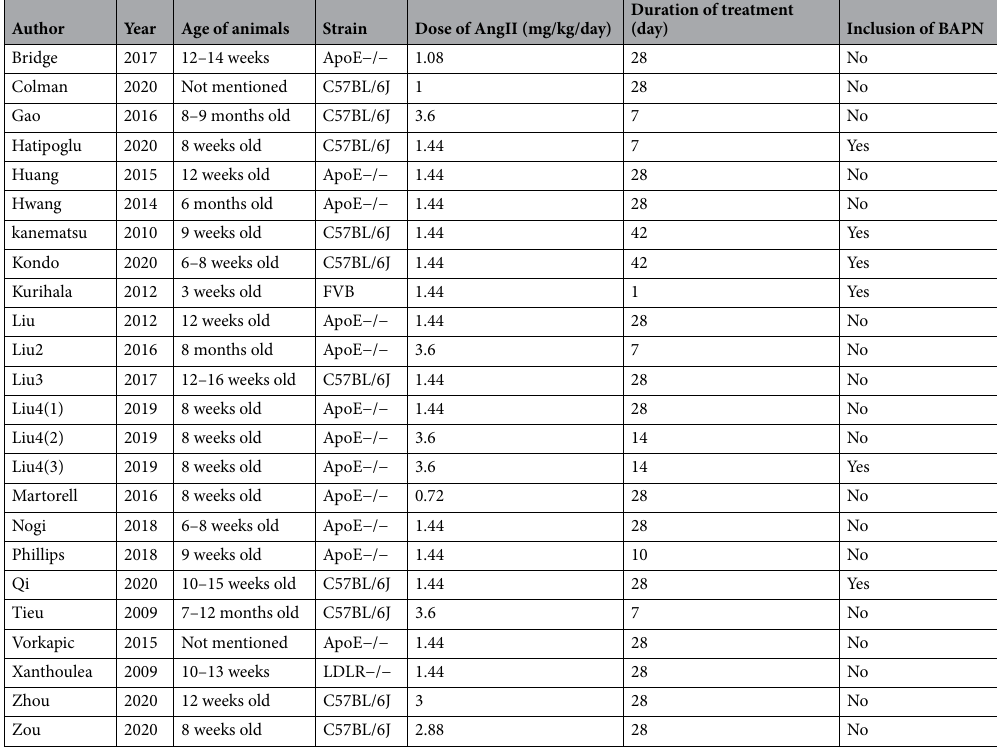
Table 1. Basic information of each